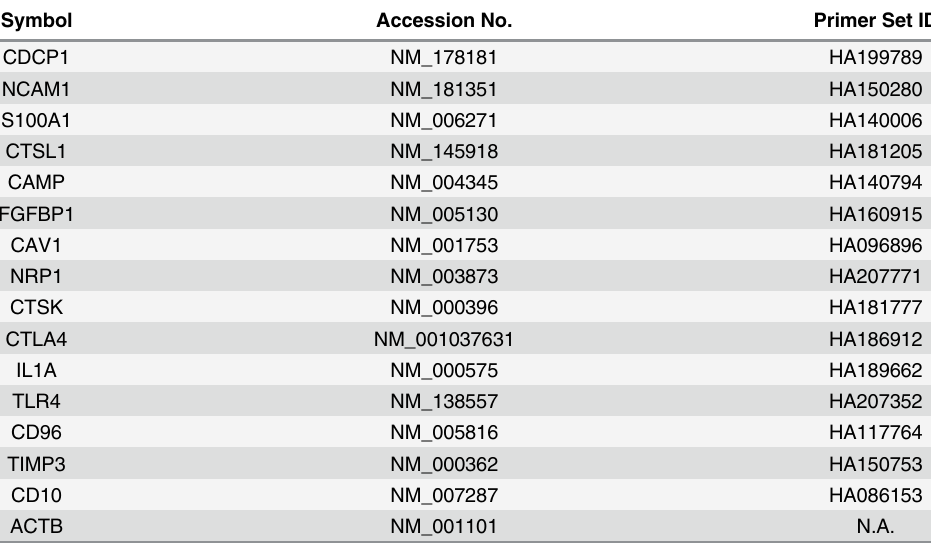
Table 1. Primer sequences used for real-time RT-PCR.